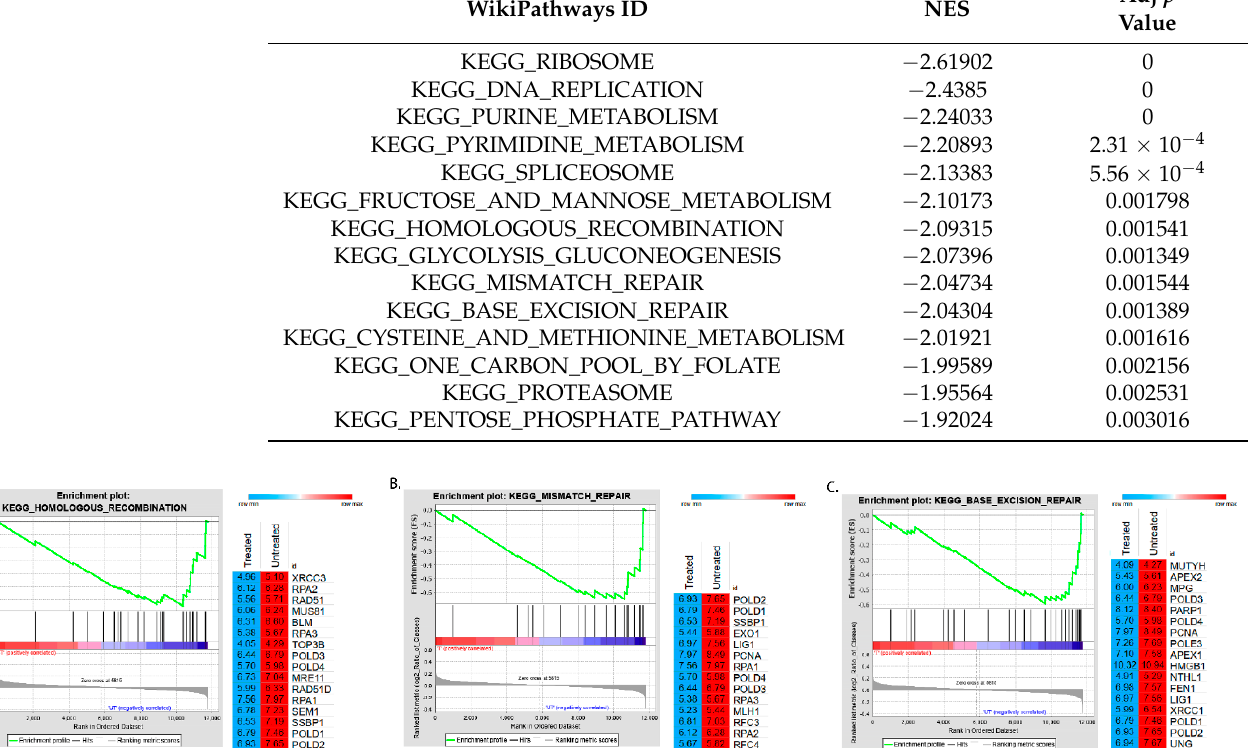
Figure 2. A gene set enrichment analysis (GSEA) of CPT-CEF-treated colon cancer cells revealed an enrichment of DNA repair mechanisms. The GSEA tool was used to make an enrichment plot of the homologous recombination ( A ), mismatch repair ( B ), and base excision repair ( C ) pathways. The genes that contributed to the leading-edge subset in the ranked list were shown in heatmaps, where the values indicated the mean normalized count data for each gene between CPF-CEF- treated and untreated samples. Red represents upregulation; blue represents downregulation. Table 2. A list of the top 13 KEGG pathways found enriched in CPT-CEF-treated colon cancer cells. Gene set enrichment analysis was performed using the KEGG database as a reference (adj p < 0.05). NES, normalized enrichment score.